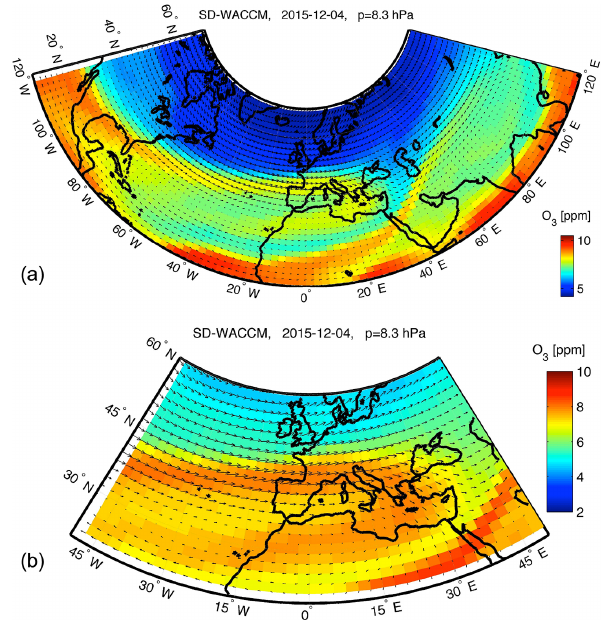
Figure 5. Water vapour distribution at 8.3hPa (34km) on 4 De- cember 2015 simulated by SD-WACCM. Water vapour is a tracer of polar vortex air. It indicates an erosion region of the polar vor- tex located above Caspian Sea. A comma-shaped, helical tongue of water vapour-rich air reaches northern Africa. The water vapour dis- tribution is anti-correlated to the ozone distribution in Fig. 4a. (b) Water vapour distribution at 8.3hPa (34km) on 4 December 2015 observed by Aura/MLS. The water vapour filaments above northern Africa agree with the SD-WACCM simulation result in (a)